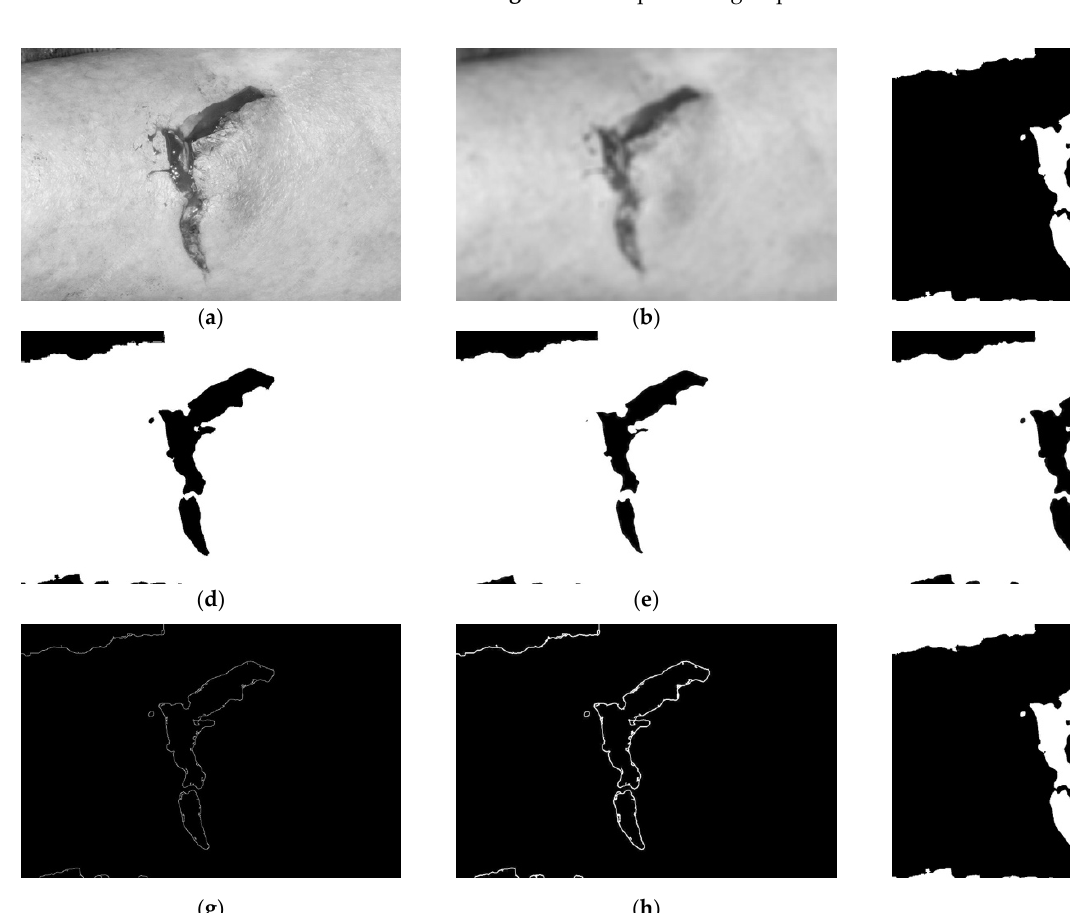
Figure 2. Data processing steps.